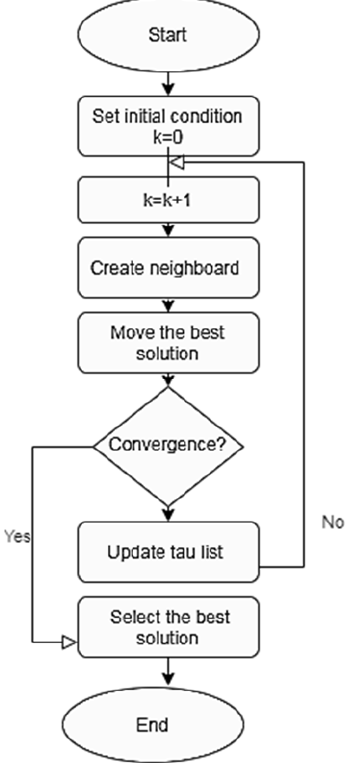
Figure A1. Tabu search flowchart.